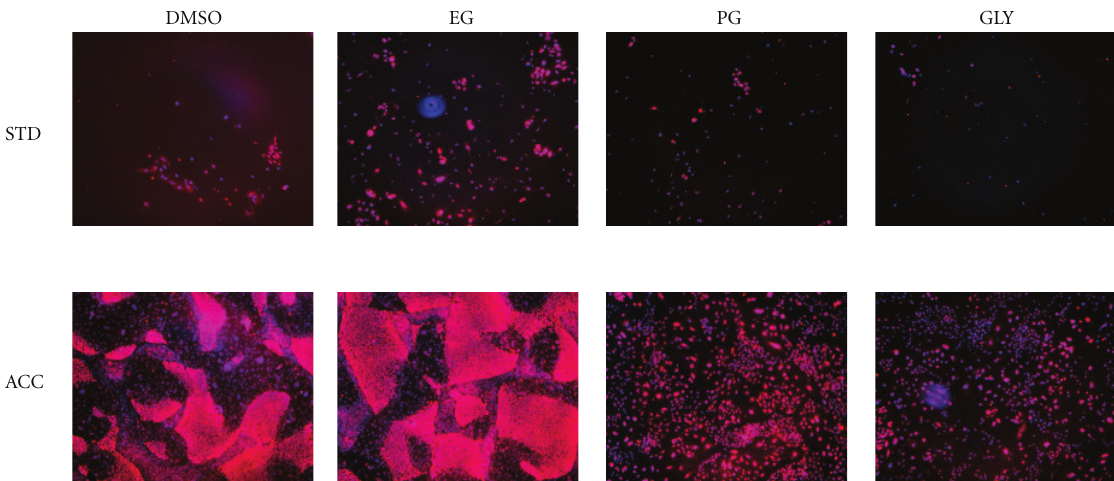
Figure 3: Cryopreservation of human iPSCs in vials. Fluorescent microscopy of human induced pluripotent stem cells. Color combined, Nanog (immune staining), and Hoechst. The intensity of hPGK-H2B-eGFP was weak (not shown) but quantifiable by Cell Lab QUANTA TM . The photos were taken on day 6 after thawing. Row STD: standard freezing with 10% of four di ff erent cryoprotective agents (CPAs) indicated in columns: dimethyl sulfoxide (DMSO) (current routine), ethylene glycol (EG), propylene glycol (PG), and glycerol (GLY). Row ACC: cryopreservation of human iPSCs after dissociation into single cells with Accutase and in the presence of ROCK inhibitor Y-27632 and